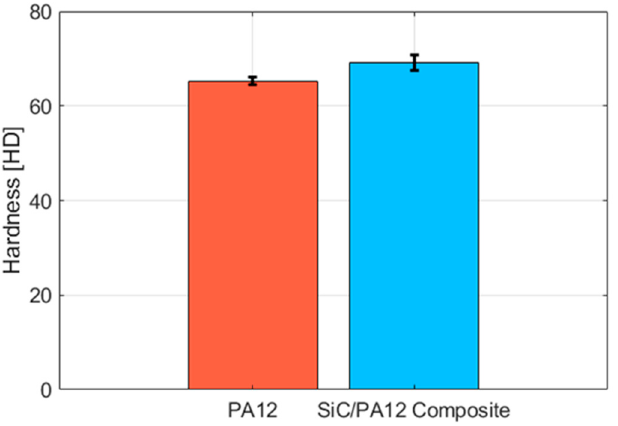
Figure 4. The shore D hardness of pure PA12 and SiC/PA12 composites.